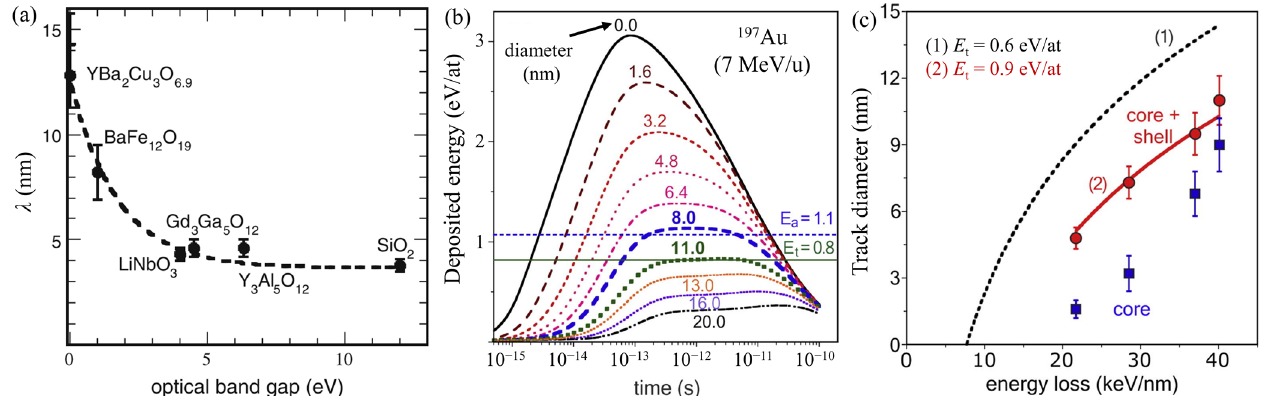
Figure 8. ( a ) Electron-phonon mean free path ( λ ) deduced from thermal spike fits versus optical band gap energy for different insulators [174]. ( b ) Inelastic thermal spike calculations of the evolution of the energy density deposited in Gd 2 Ti 2 O 7 vs. time for different diameters of the track cylinder (given in nm) for Au ion (7 MeV/u). Horizontal lines indicate the required energy density to obtain track diameters in agreement with experimental data from high-resolution TEM [135]. ( c ) Experimental track diameters for different ion beams in Gd 2 Ti 2 O 7 from high-resolution TEM measurements as a function of dE / dx : core-shell tracks (red circles) and amorphous track cores (blue squares). The solid red and dashed black curves are the results of thermal spike calculations based on E t = 0.90 eV/at and E t = 0.56 eV/at, respectively [135]. ( a ) Reproduced with permission from Reference [174], Copyright © Springer Nature 2009; ( b , c ) Reproduced with permission from Reference [135], Copyright © Elsevier 2014.